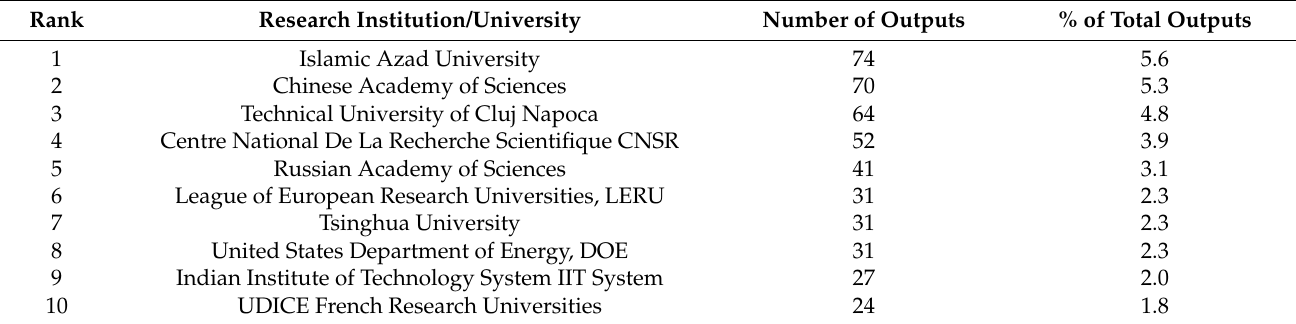
Table 7. Top 10 research institutions on fractal theory in thin film deposition and technologies .